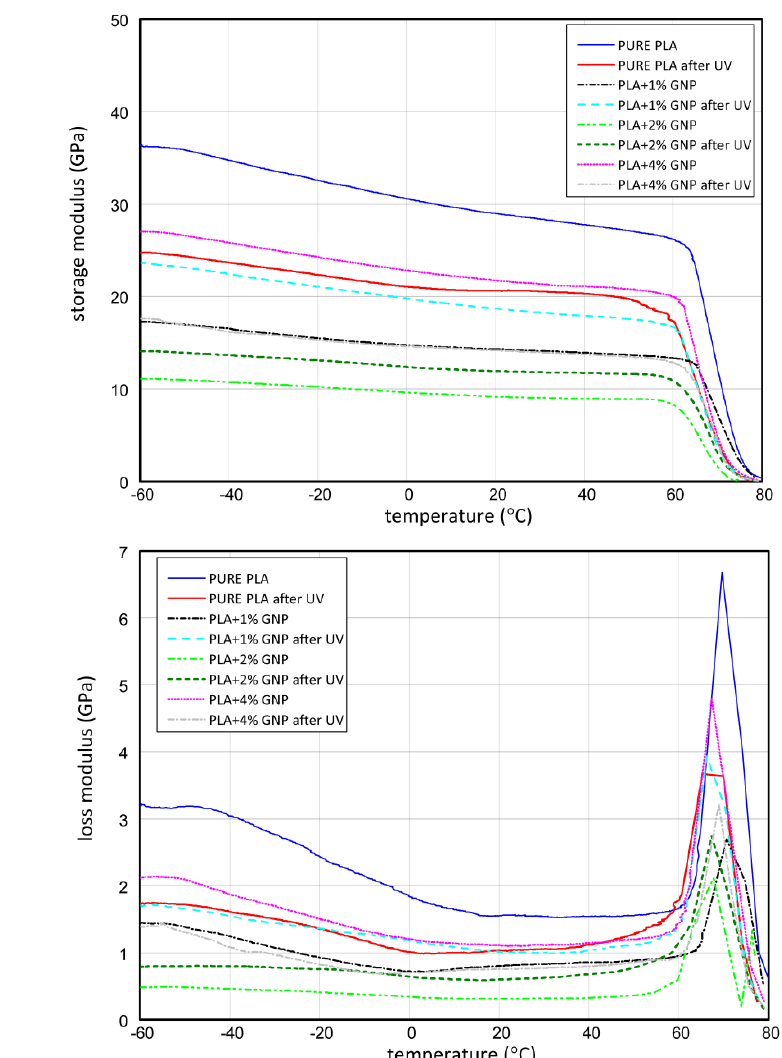
Figure 7. The curves of storage modulus ( a ) and loss modulus ( b ) in range of − 60 °C up to 80 °C.